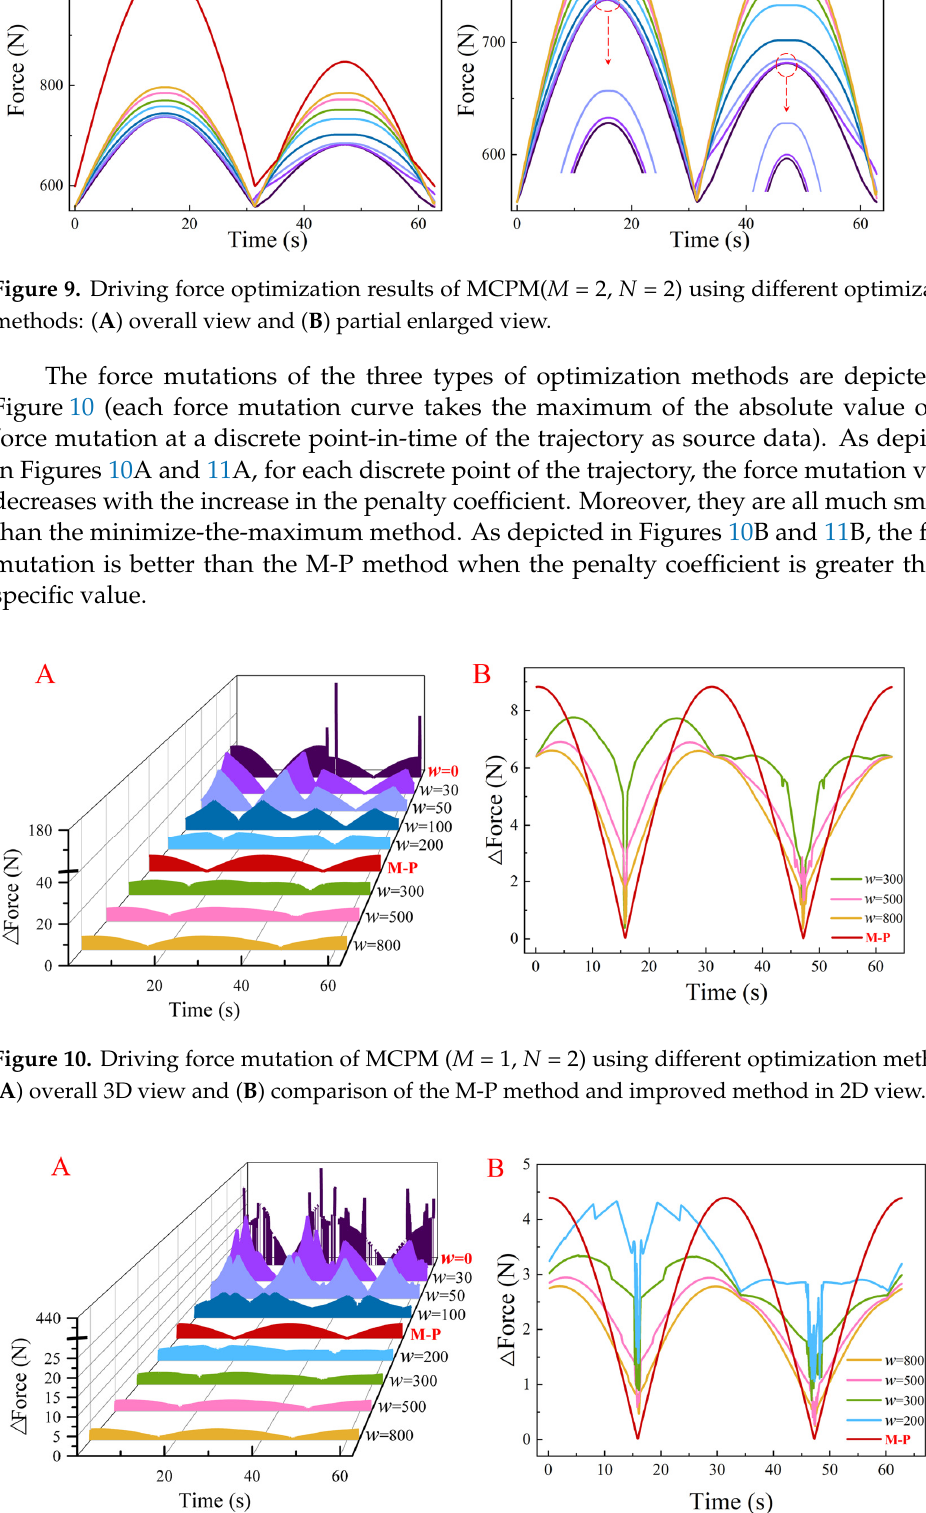
Figure 8. Driving force optimization results ( M = 1, N = 2) using different optimization methods: ( A ) overall view and ( B ) partial enlarged view.